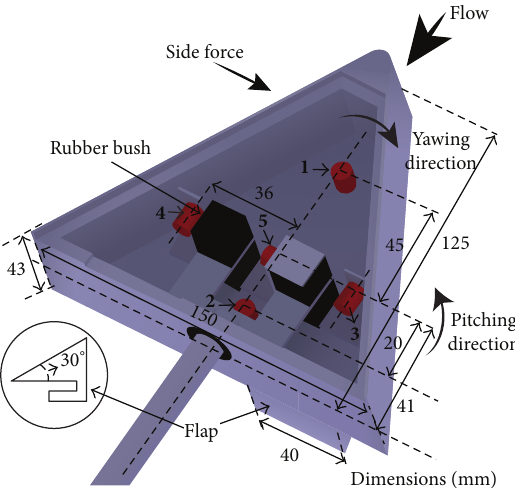
Figure 3: Schematic of the test model. Labels 1–5 indicate accelerometers. Accelerometer model (all) 352C67 of PCB Piezotronics (USA). Sensitivity ≈ 100mV/g.